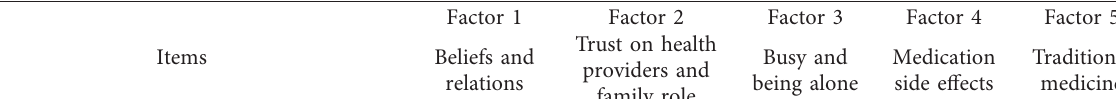
Table 5: Rotated factor matrix: the factors affecting the hypertensive treatment adherence